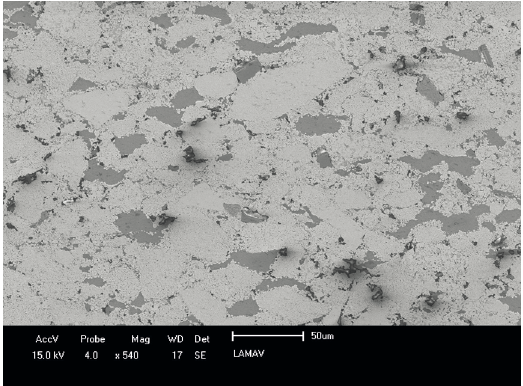
Figure 5. Structure of alloy REC. Elongated and aligned Co particles and particles of the WC-Co powder.